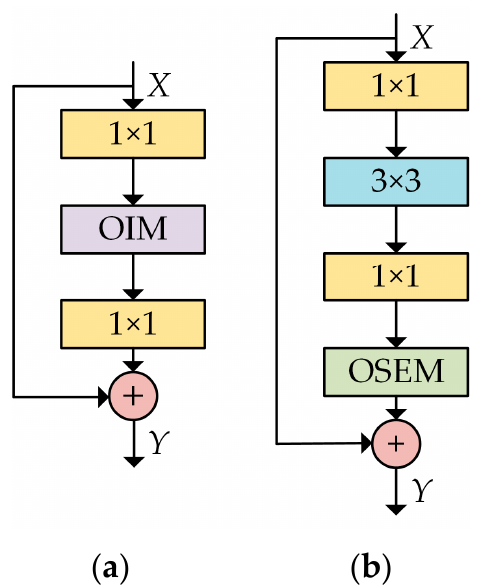
Figure 8. ( a ) The basic block of OIM-ResNets; ( b ) the basic block of OSEM-ResNets. The input is denoted by X , and the output is indicated as Y .